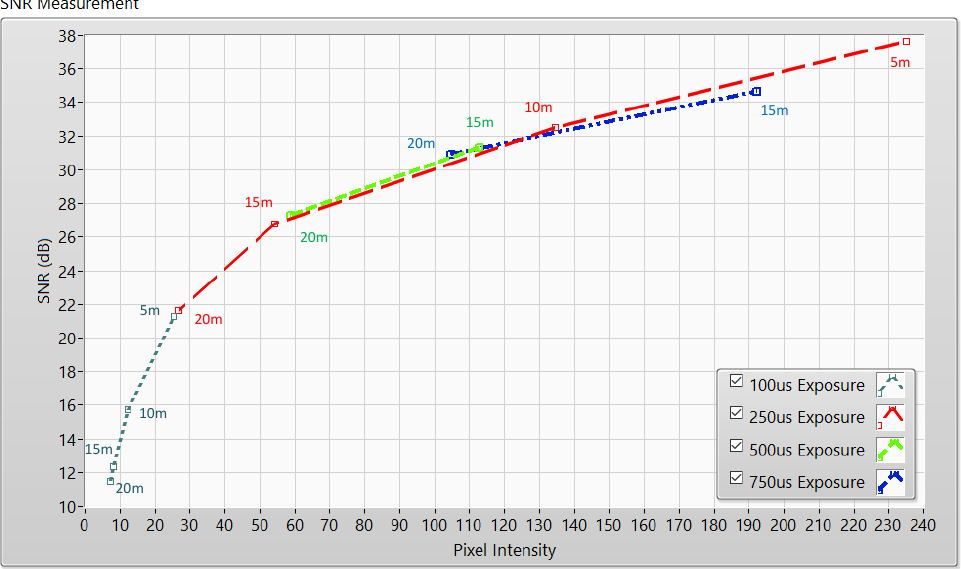
Figure 10. SNR measurement with different communication distances.